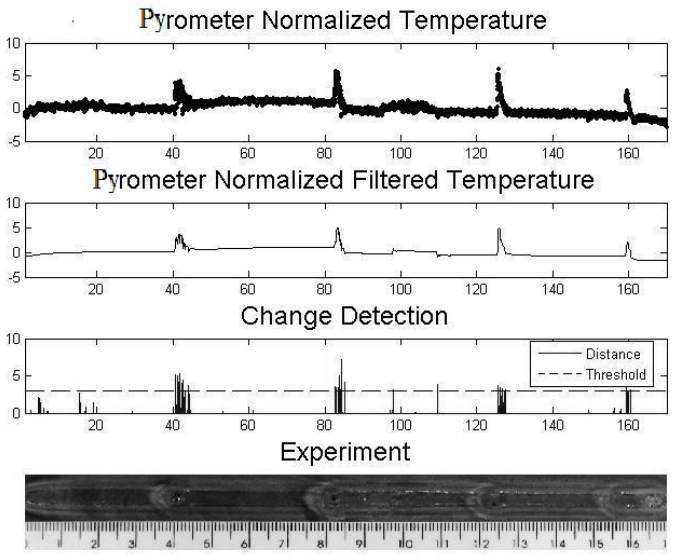
Figure 8. Plate with water defects and change detection